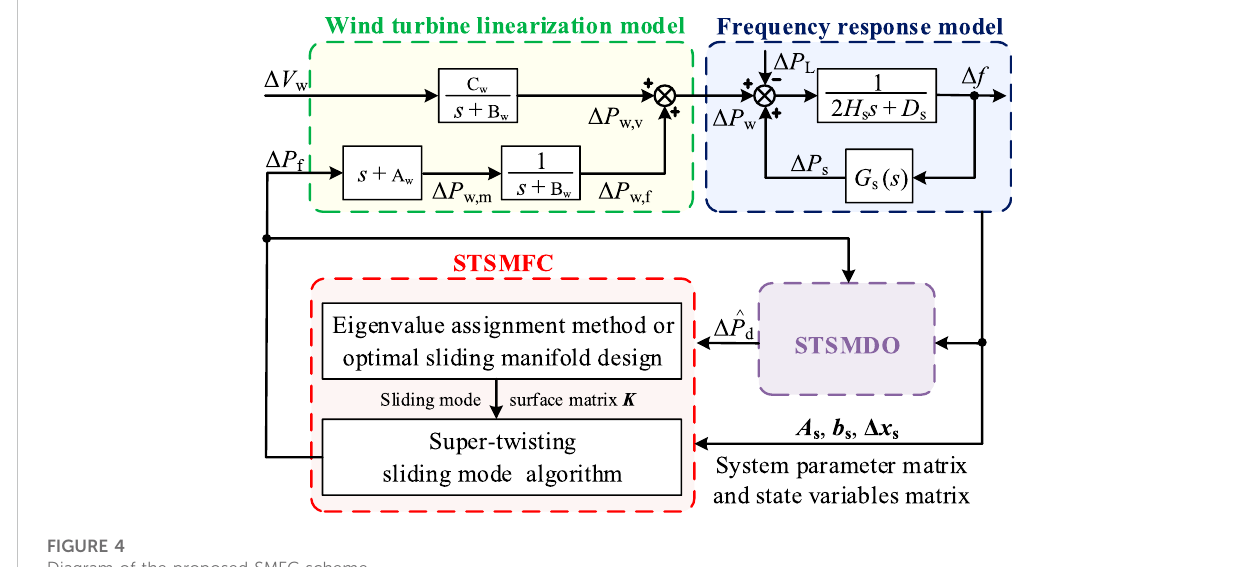
FIGURE 4 Diagram of the proposed SMFC